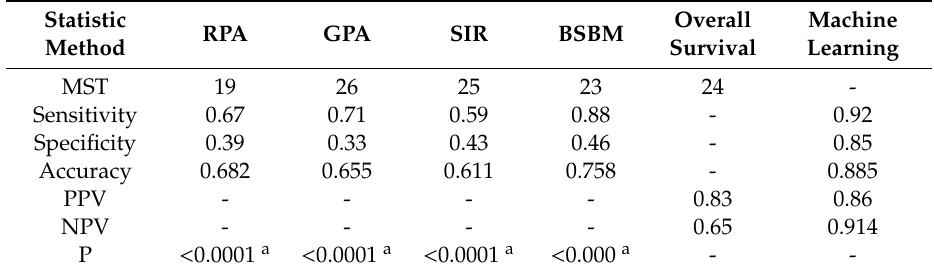
Table 4. Comparison of predictive performance between machine-learning and statistic methods in the test